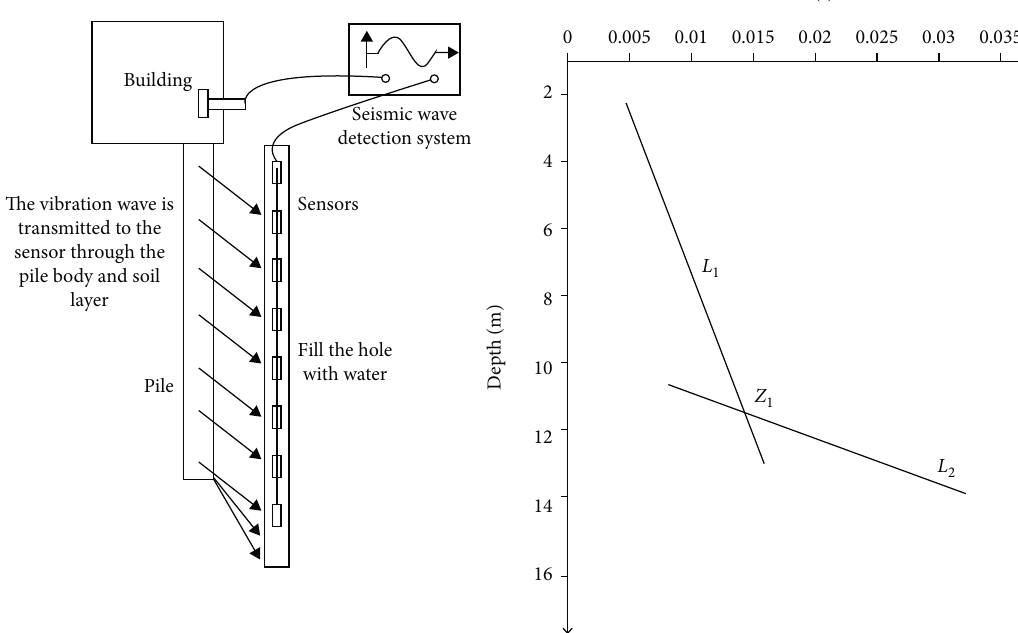
Figure 1: Schematic diagram of the principle of parallel seismic method.